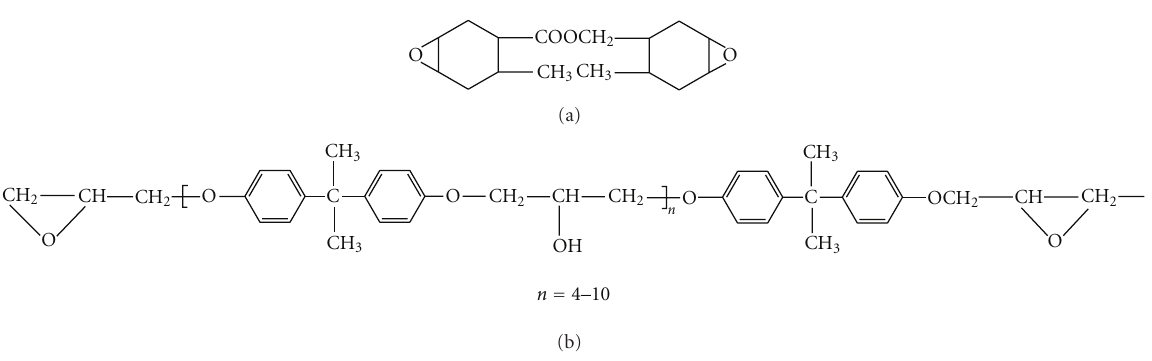
Figure 9: Chemical structures of two kinds of epoxy resin (a) cycloaliphatic-epoxy, (b) bisphenol A epoxy.